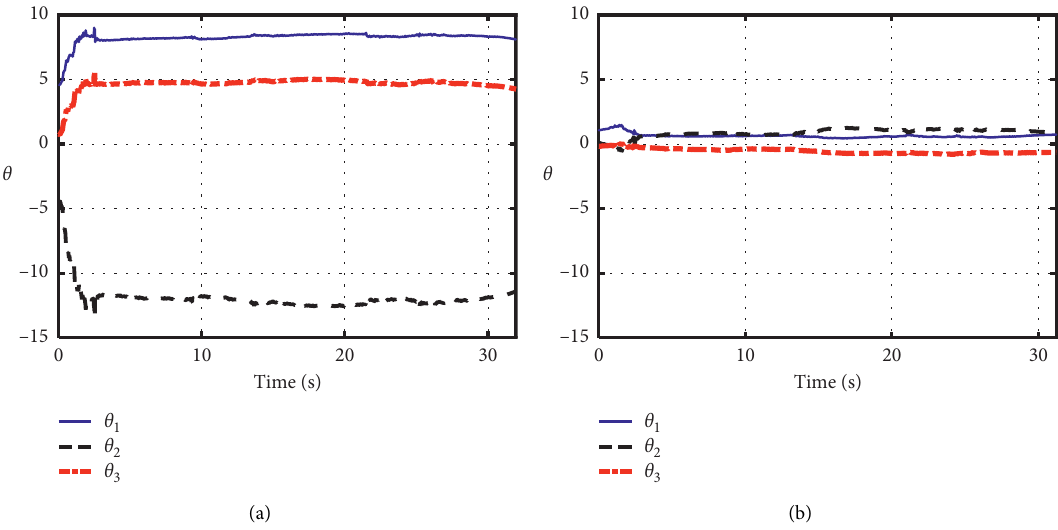
Figure 13: Estimated parameters in RTHS with seismic excitation. (a) The SADC method. (b) The ADC